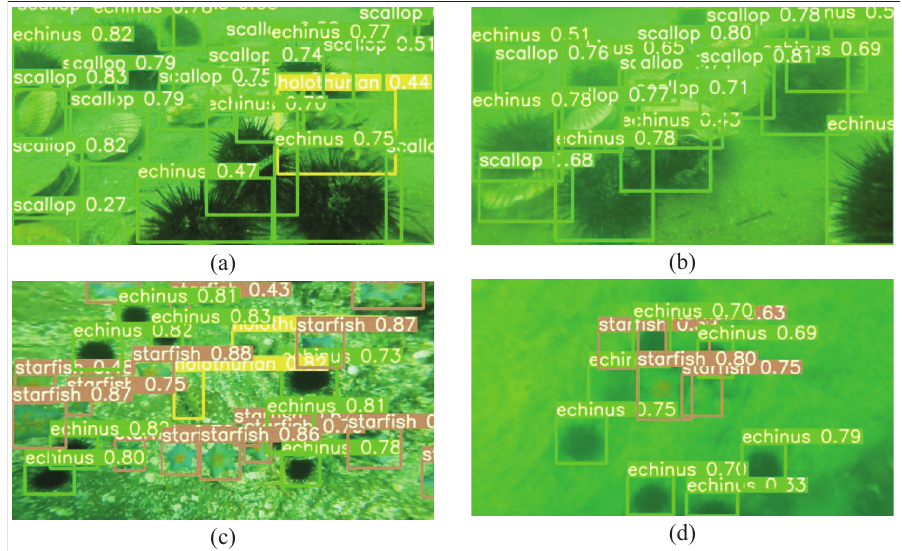
Figure 10. Detection results of different underwater scenes. ( a ) Clear scene at close range, ( b ) blurred scene at close range, ( c ) clear scene from a long distance, and ( d ) blurred scene from a long distance.